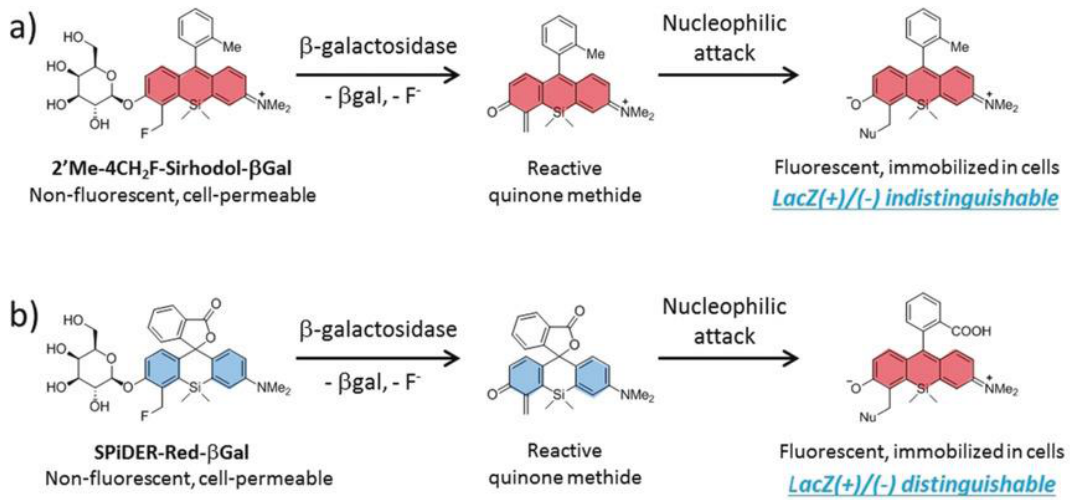
Figure 11. ( a ) Activation of nonfluorogenic 2 ′ Me-4CH2F-Sirhodol- βGal and ( b ) SPiDER-Red- βGal . Adapted with permission from [55], copyright 2018 John Wiley and Sons.